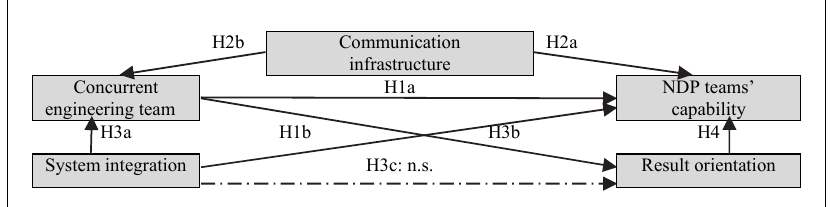
Fig. 1. Path model of constructs depicting combined effect of teamwork and its associated factors on NPD team’s